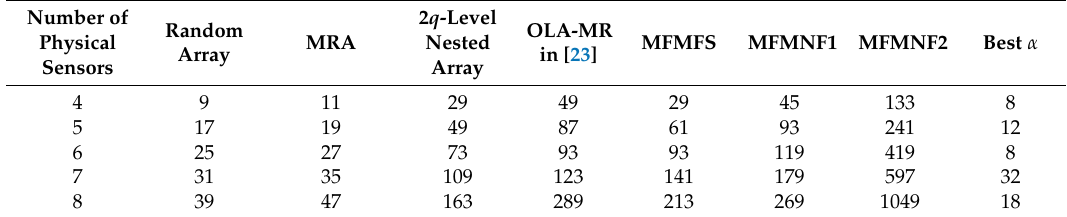
Table 1. DOFs of different